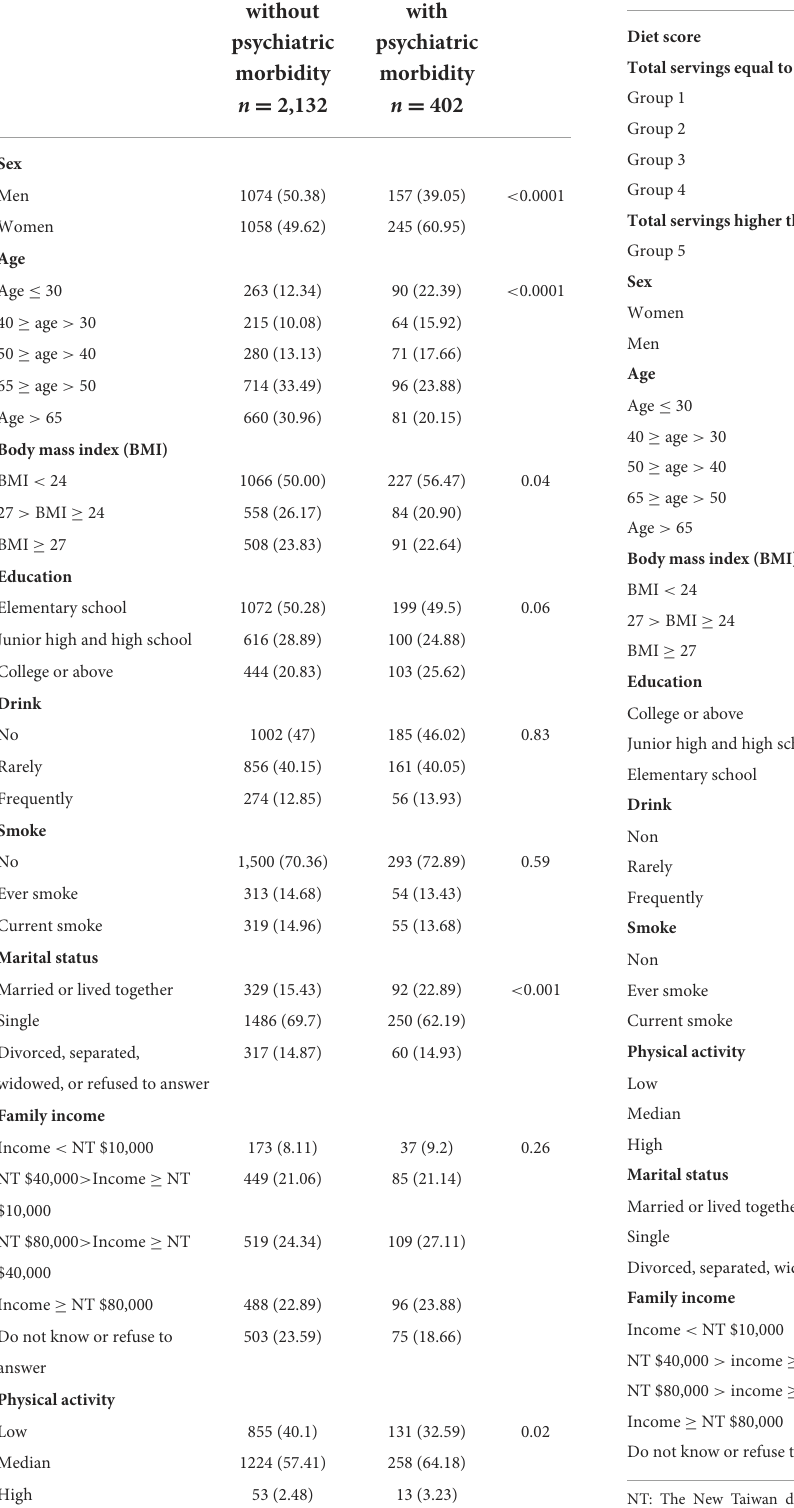
TABLE 1 Demographic characteristics of study participants ( n = 2,534).